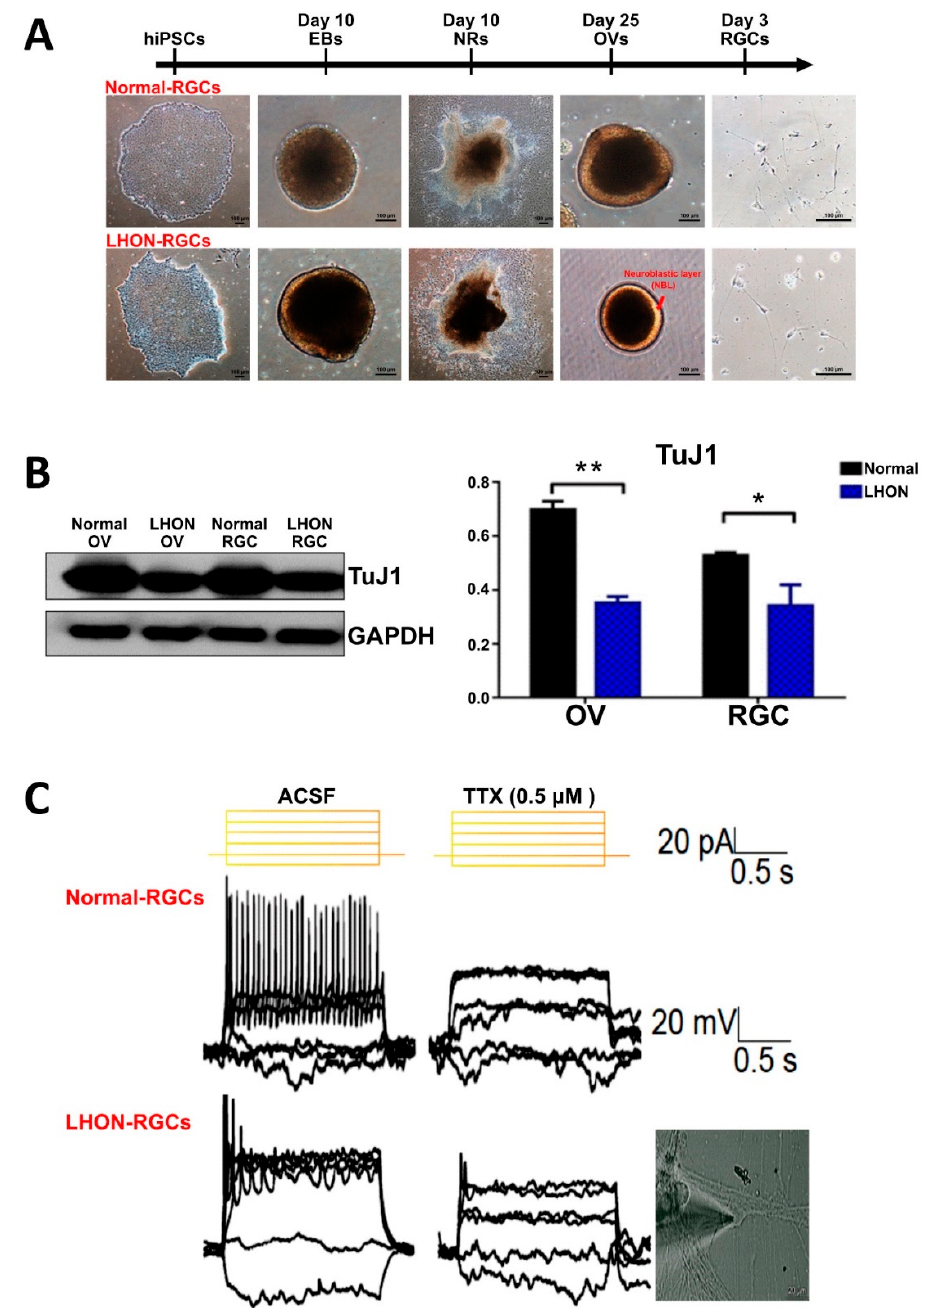
Figure 3. Enriched single-cell LHON-RGC population recapitulates LHON pathological features. ( A ) Bright field images showing morphologies of wild type (normal) and LHON-specific hiPSCs, EBs, NRs, OVs, and 2-day RGCs. Scale bar: 100 µ m. ( B ) Western blot showing protein expression level of TuJ1 in OVs and RGCs derived from normal and LHON-specific hiPSCs. Glyceraldehyde 3-phosphate dehydrogenase (GAPDH) used as a loading control. ( C ) Electrophysiological analysis of day-21 Normal-RGCs and LHON-RGCs. Patch clamp was used to detect the spikes of action potential of cells submerged in tetrodotoxin-free artificial cerebrospinal fluid (ACSF) and ACSF containing 0.5 µ M tetrodotoxin for negative control (TTX). * p < 0.05, ** p < 0.01. 3.4. α -Amino-3-Hydroxy-5-Methylisoxazole-4-Propionic Acid (AMPA) Receptors and AMPA Scaffold Proteins are Downregulated in LHON-RGCs